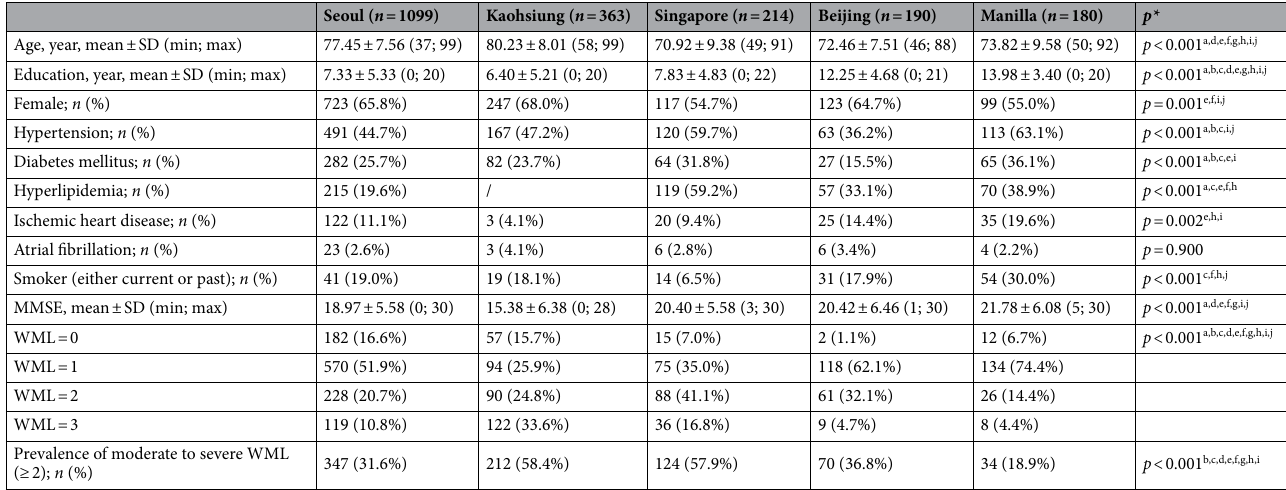
Table 3. Clinical demographics of the AD/MCI group. This table showed the clinical demographics of the AD/MCI group. a Beijing versus Seoul. b Beijing versus Manilla. c Beijing versus Singapore. d Beijing versus